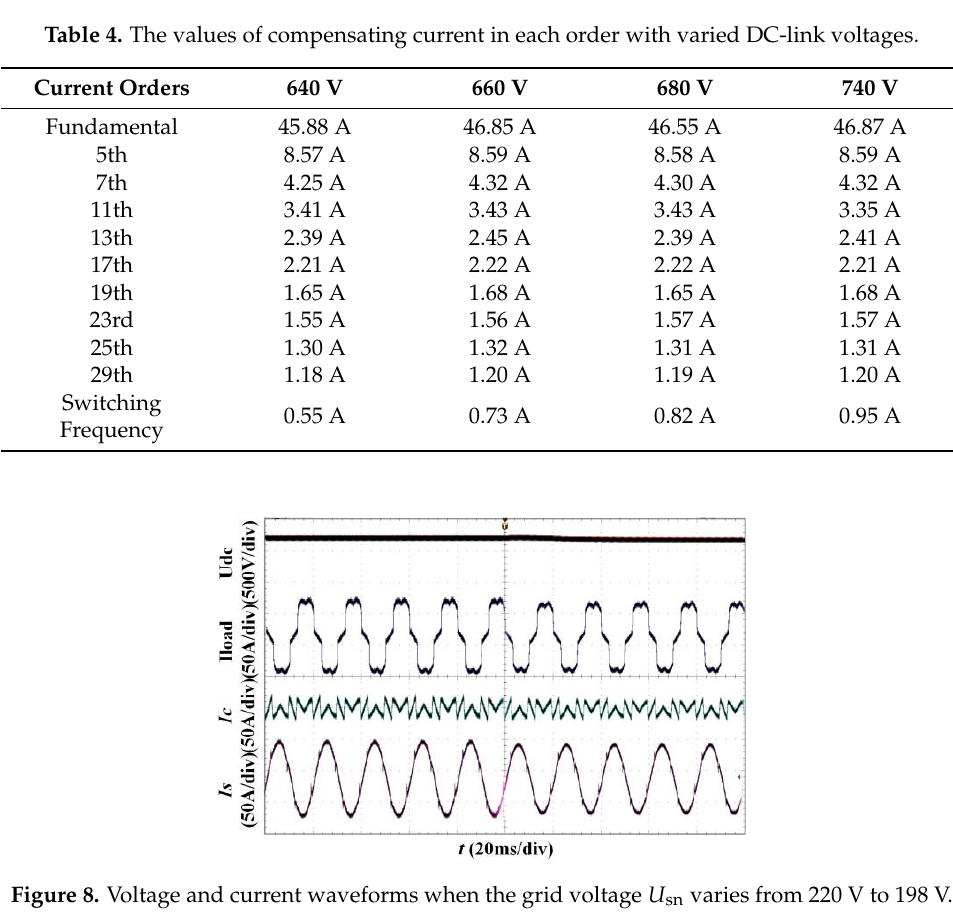
Figure 8. Voltage and current waveforms when the grid voltage U sn varies from 220 V to 198 V.